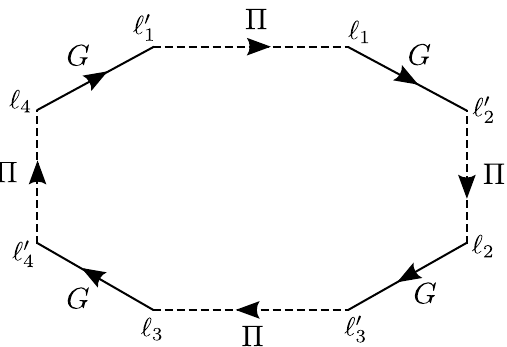
Figure 1 . The Feynman diagram for a single-trace contribution tr( G Π) n to the CFT partition function, drawn for n = 4. Dashed lines represent the bilocal sources Π( ℓ ′ , ℓ ). Solid lines represent propagators G ( ℓ, ℓ ′ ). Note that the diagram is in coordinate space rather than momentum space, and there is no loop integration